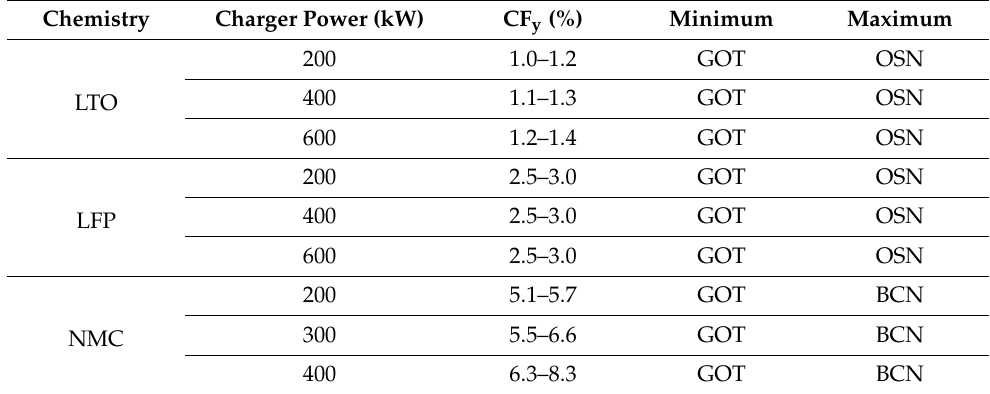
Table 9. Summary of CF y results for sensitivity to the charger power.